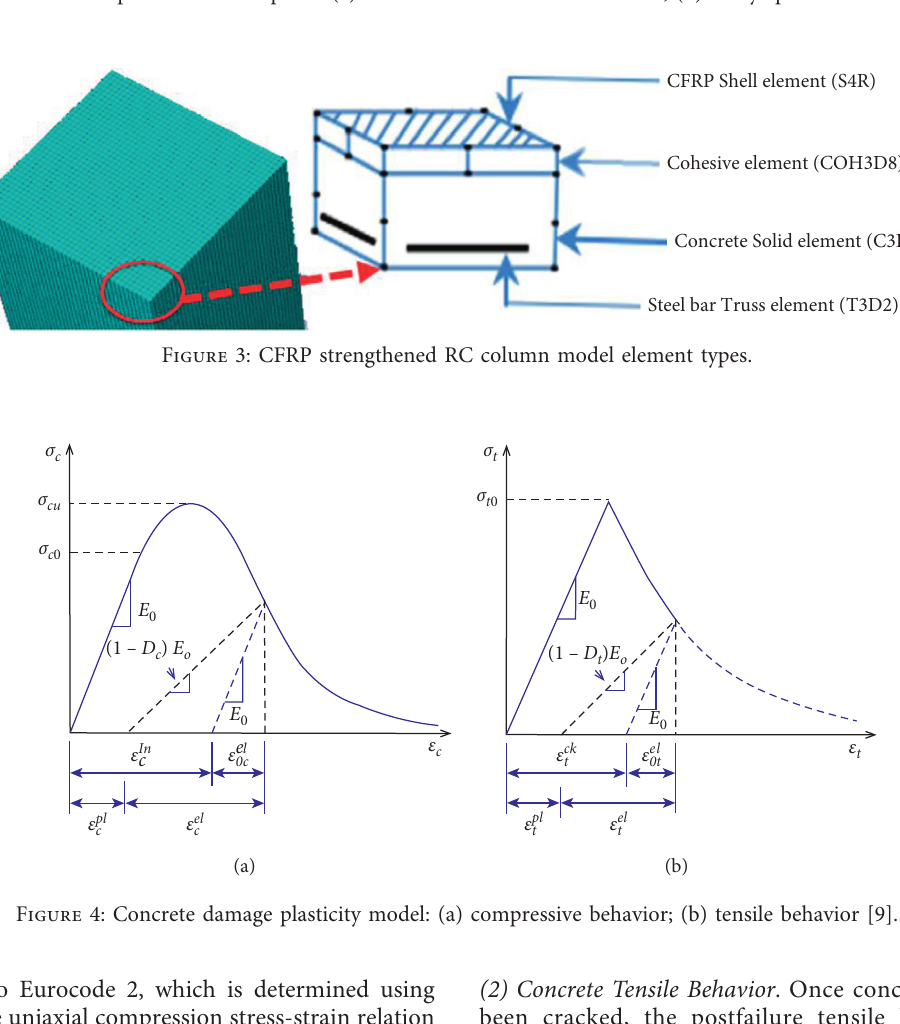
Figure 2: FE model parameter description: (a) locations of eccentric axial loads; (b) study specimen